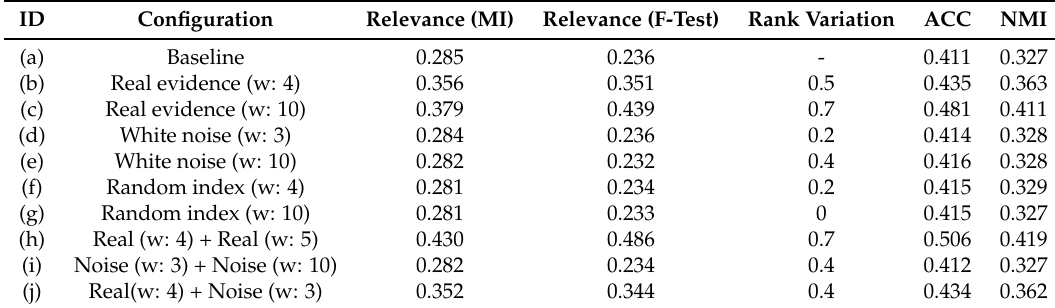
Table 4. The REUTERS-100k dataset results: real corresponding evidence with width 4 represent the four root categories of the RCV1 dataset. The width 10 evidence represents the labelset of REUTERS-100k (subset of RCV1 labels). Width 5 evidence is a categorisation of width 10 evidence into 5 groups.